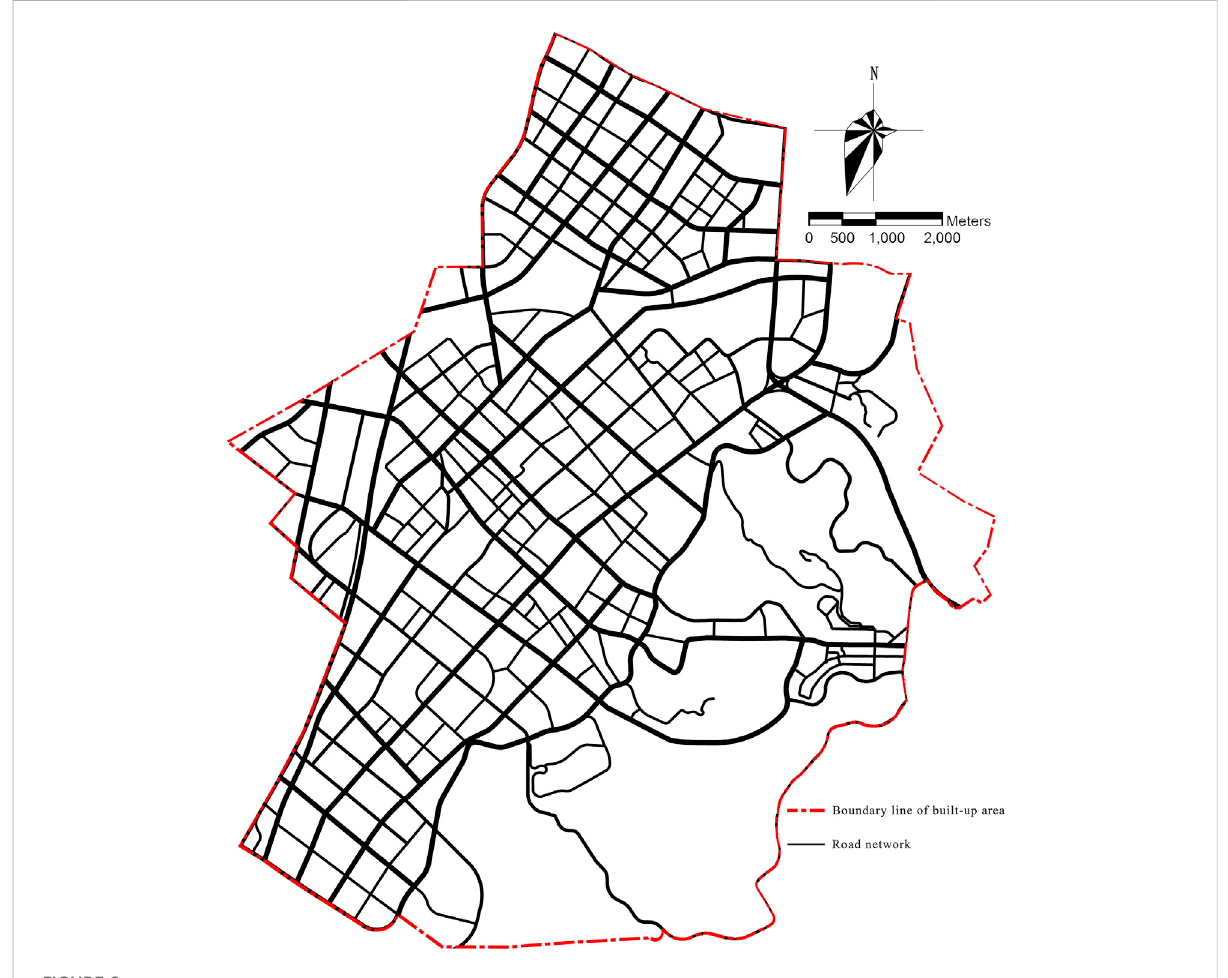
FIGURE 2 Current situation of urban roads in Yuxi City